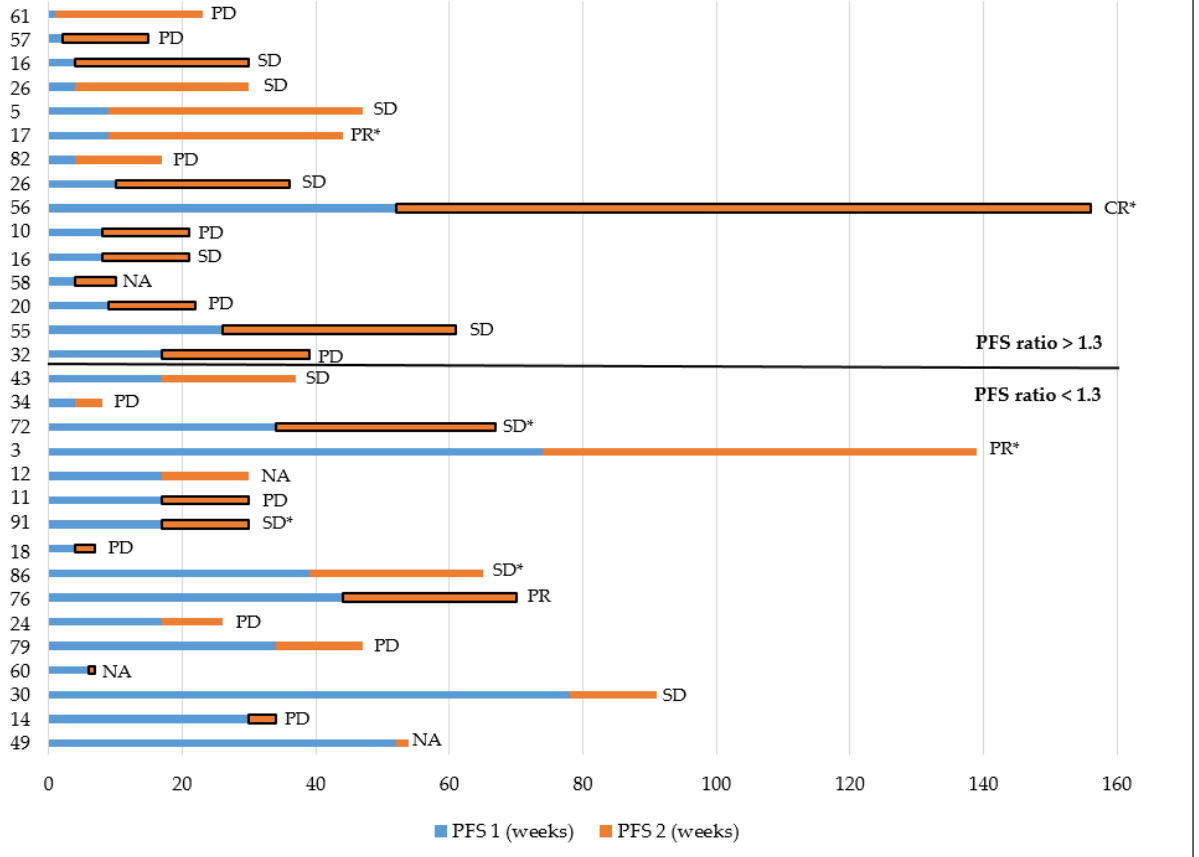
Figure 5. Progression-free survival (PFS) under the immediate last standard treatment line (PFS1, blue bar) before next- generation sequencing (NGS), followed by NGS-recommended treatment (PFS2, orange bar). Framed bars represent off-label therapy and * denotes ongoing treatment with targeted therapy. In four patients, the response assessment was not available (NA) as the patient died before the response could be evaluated. CR, complete response; PD, progressive disease; PR, partial response; SD, stable disease.